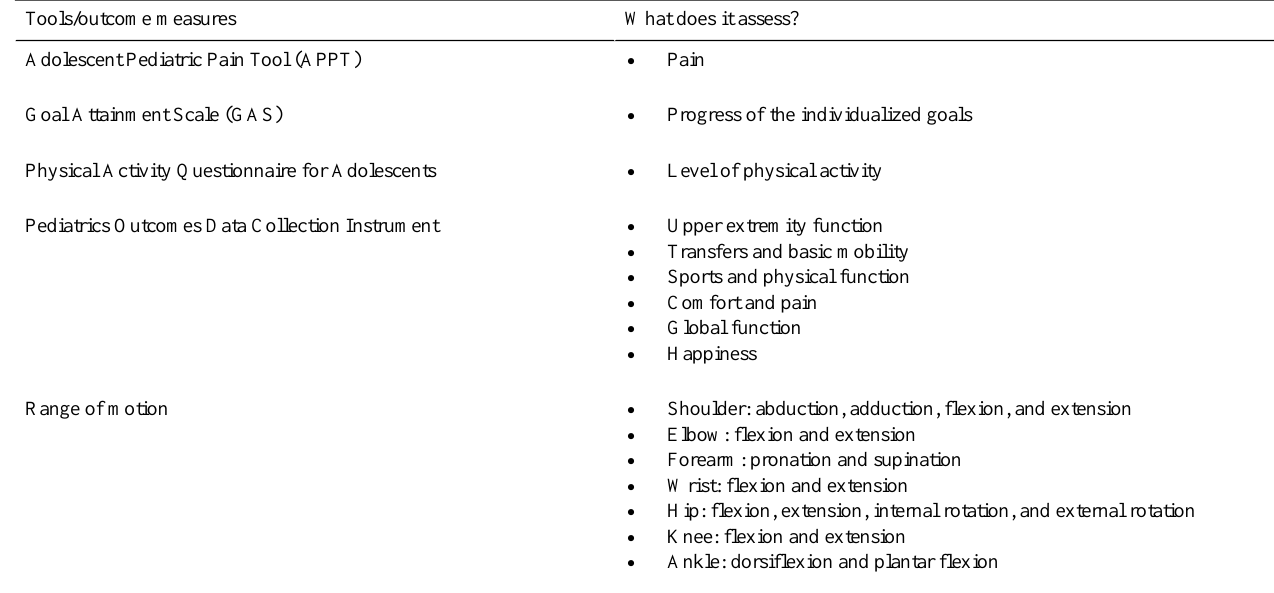
Table 2. Summary of outcomes used to determine effectiveness.